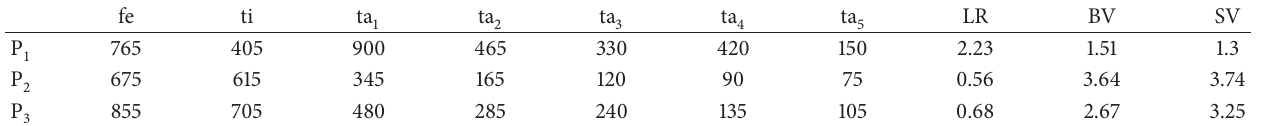
Table 1: Lengths ( 𝜇 m) and proportions of leg